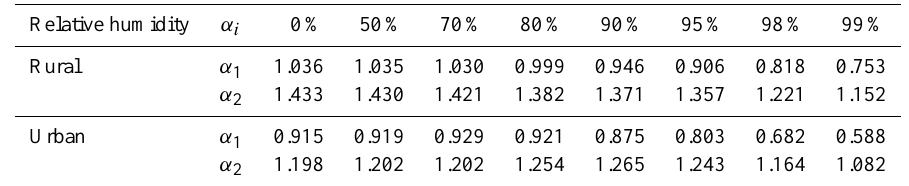
Table 2. Ångström exponents for the two spectral bands of the modified Ångström’s law, the aerosol mixtures and relative humidity values. Ångström exponents are computed as described in Sect. 3.1 Relative humidity α i 0% 50% 70% 80% 90% 95% Rural α